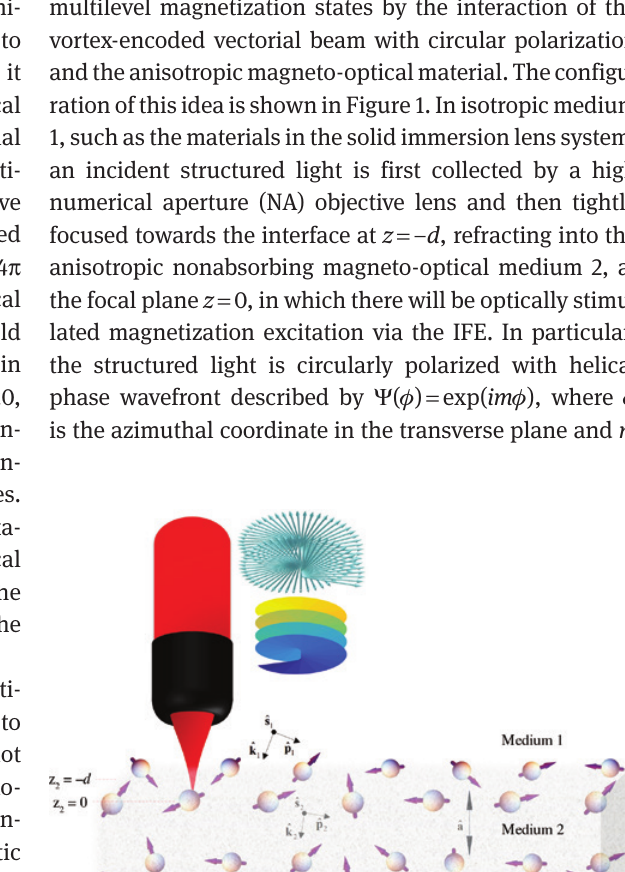
ˆ k and ˆ k are unit wave 1 2 ˆ ˆ, s p and ˆ ˆ, s p are the 1 1 2 2